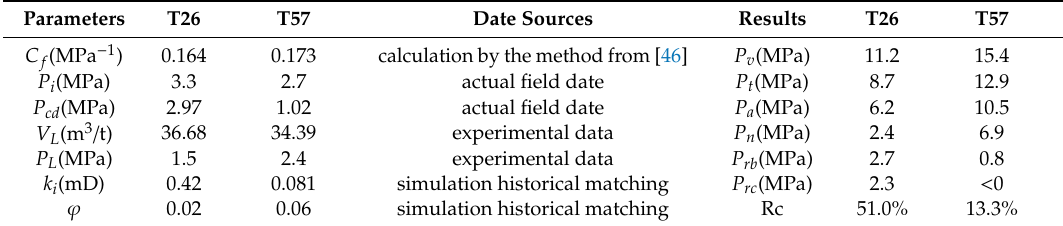
Table 5. The geologic parameters and calculation results of well T26 and